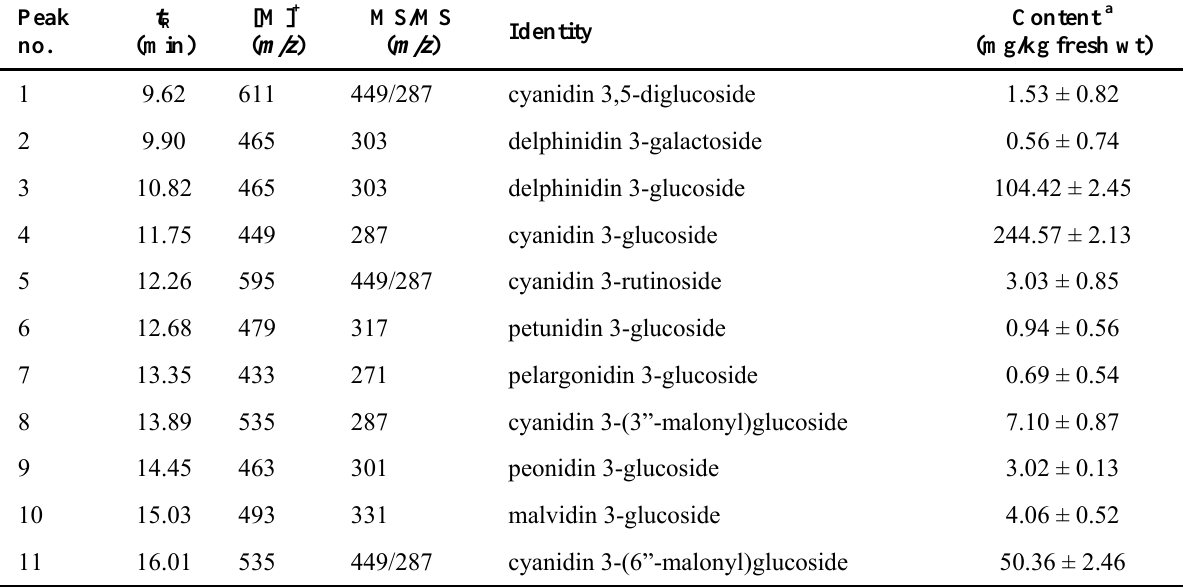
Table 1. Identification and contents of anthocyanins in Amazon grape